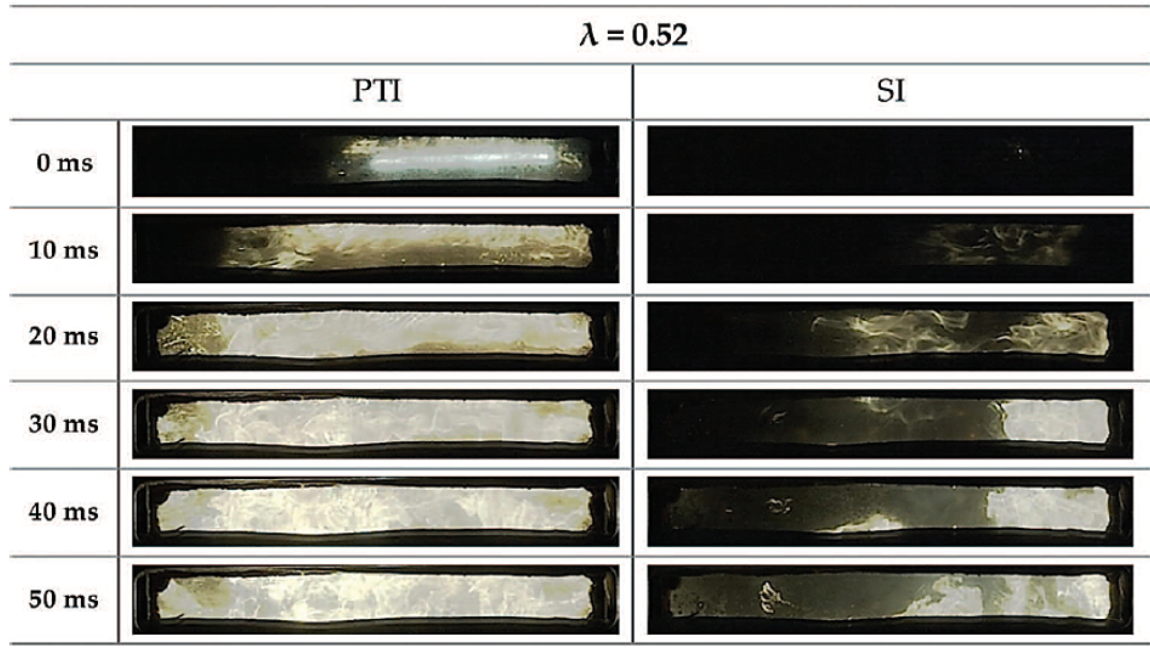
Figure 7: Frame sequences related to the combustion of air/ gasoline mixture with λ = 0.52; comparison between the ignition / combustion by MWCNTs/nEMs photo-thermal ignition (PTI) and spark ignition (SI)